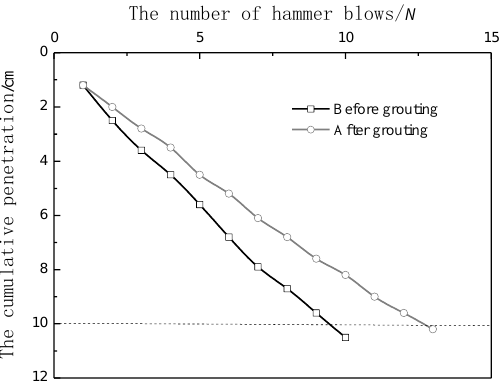
Figure 11. Comparison of dynamic penetration test of No. 2 pile before and after grouting.